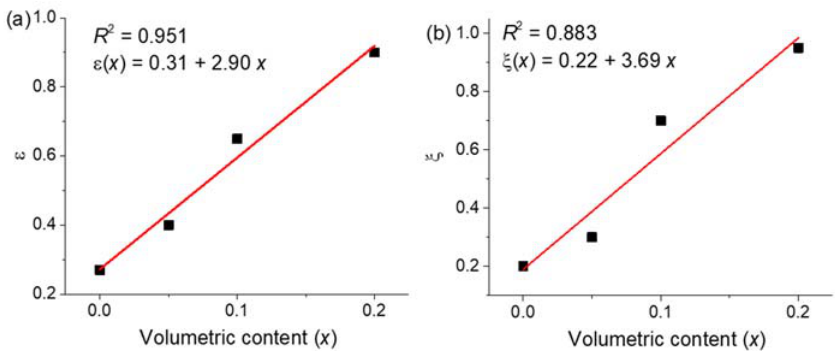
9 of 15 Figure 5. A comparison of the (Newtonian) viscosity parameter 𝜂 (cid:3036) ( x ) in each mode against the filler volumetric content x (4.3%, 9.2% and 21.1%). Lines fitting based on Equation (8) (PTT model parameters in Table 1) with x > 0. ( a ) mode 1; ( b ) mode 2; ( c ) mode 3; ( d ) mode 4. Figure 6 shows similar fittings for ε and ξ for PP composites with various filler content, also now including the zero filler case ( x = 0), thus the neat reference case. In Figure 5a, a linear increase of ε is observed as the filler volumetric content increases,